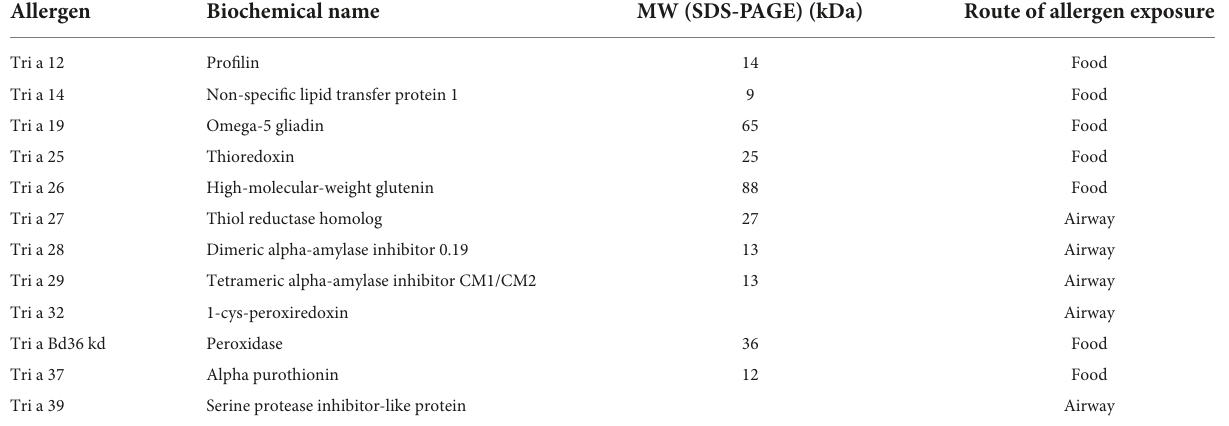
TABLE 1 Triticum aestivum (bread wheat)